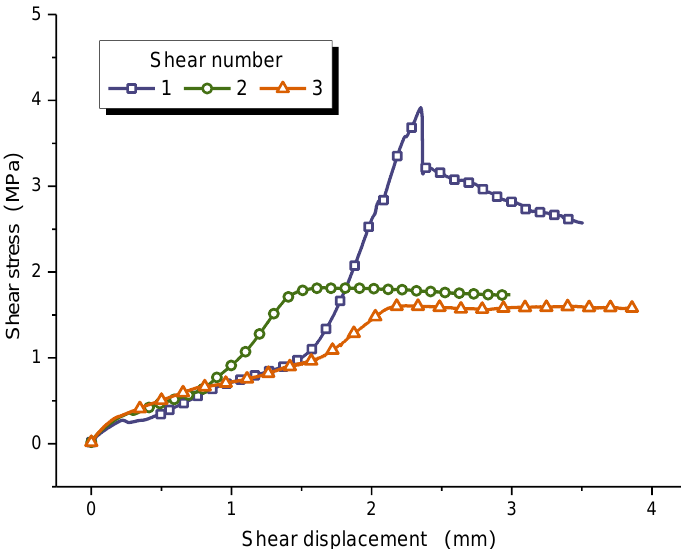
Figure 7. The shear stress vs shear displacement curves of sample CD-1 in each shearing.